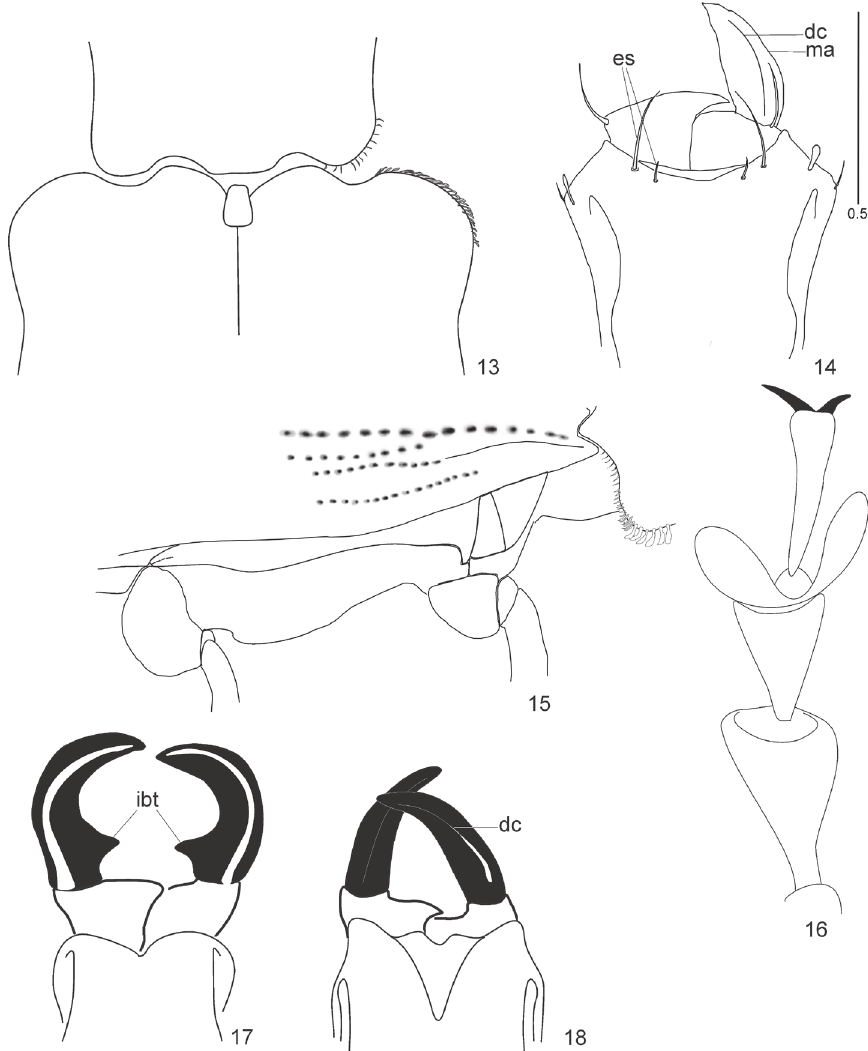
cesses dentate 18 Naupactus fatuus Boheman, 1833, mandibular processes simple (Naupactini). Abbrevia- tions: dc dorsal carina of mandibular process, ibt interobasal tooth of mandibular process, es epistomal setae, ma mandibular process. Scale bar: 1 mm (Figs 13, 15 ); 0.5 mm (Figs 14, 16 ); not in scale (Figs 17, 18